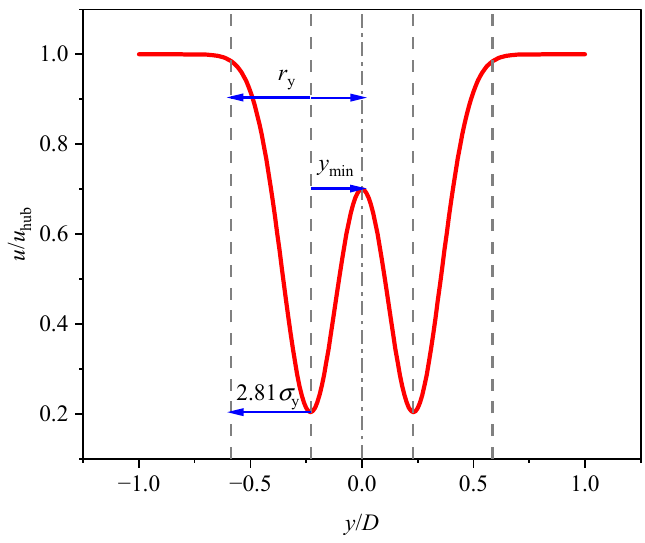
Figure 1. Schematic diagram of a double-Gaussian function.